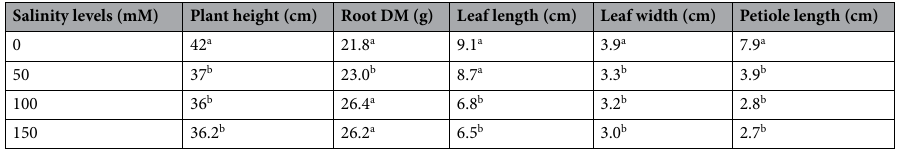
Table 2. Mean comparisons for the effects of salinity (0, 50, 100, and 150 mM NaCl) on plant height, root DM, leaf length, leaf width, and petiole length of Tanacetum balsamita plants grown hydroponically in perlite. Significant differences among salinity treatments are indicated by the different Latin letters according to Duncan’s multiple range test.